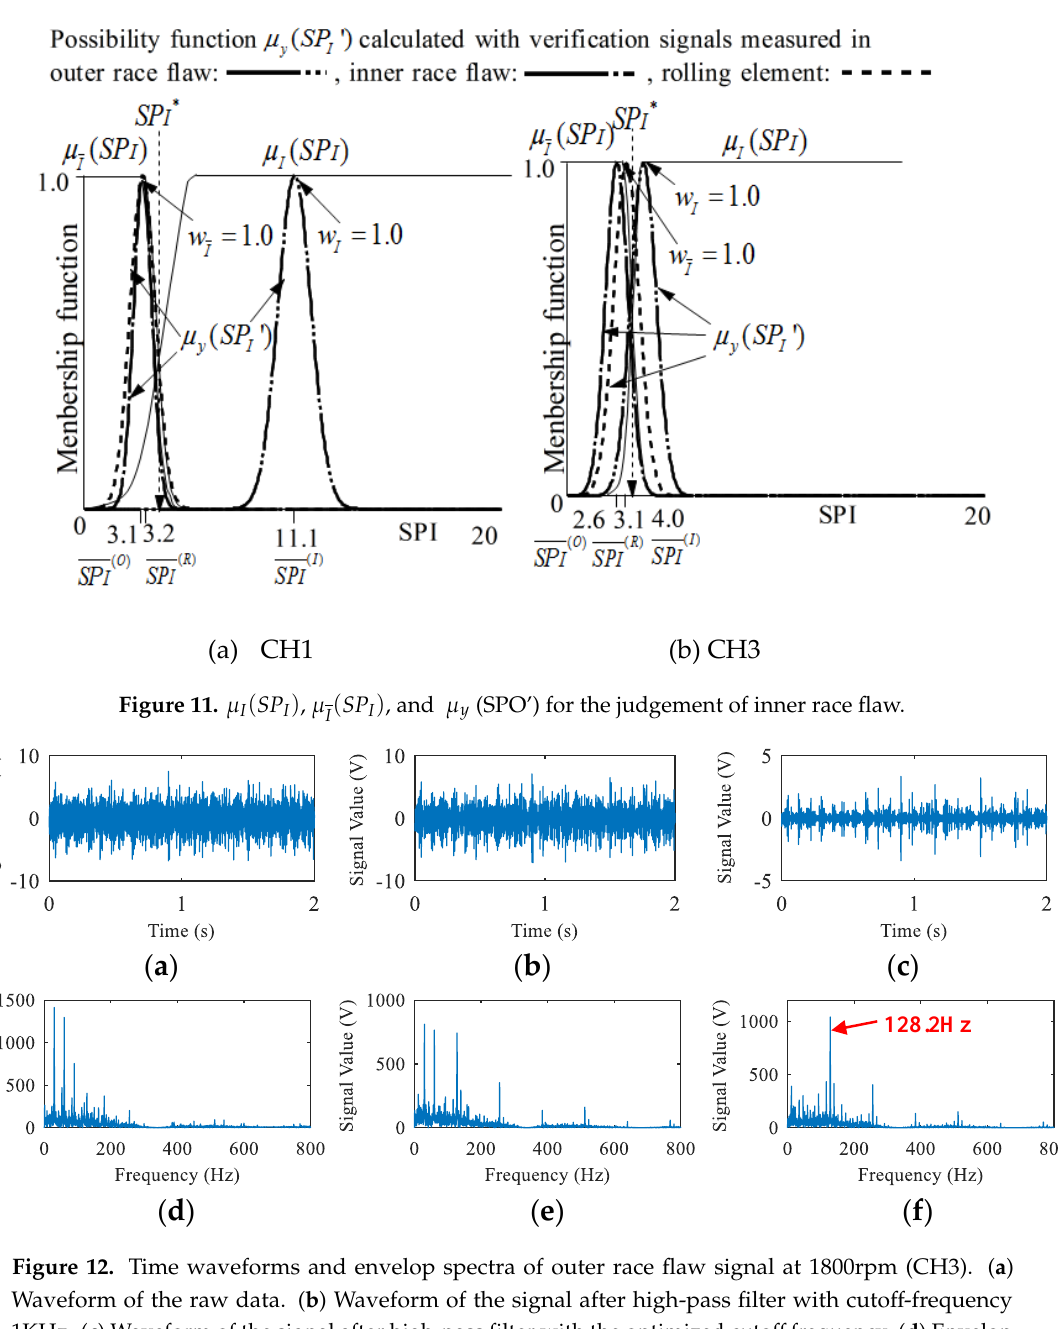
Figure 12. Time waveforms and envelop spectra of outer race flaw signal at 1800rpm (CH3). ( a ) Waveform of the raw data. ( b ) Waveform of the signal after high-pass filter with cutoff-frequency 1KHz. ( c ) Waveform of the signal after high-pass filter with the optimized cutoff frequency. (d) Envelop spectrum of the raw data. ( e ) Envelop spectrum of the signal after high-pass filter with cutoff- frequency 1KHz. ( f ) Envelop spectrum of the signal after high-pass filter with the optimized cutoff frequency.